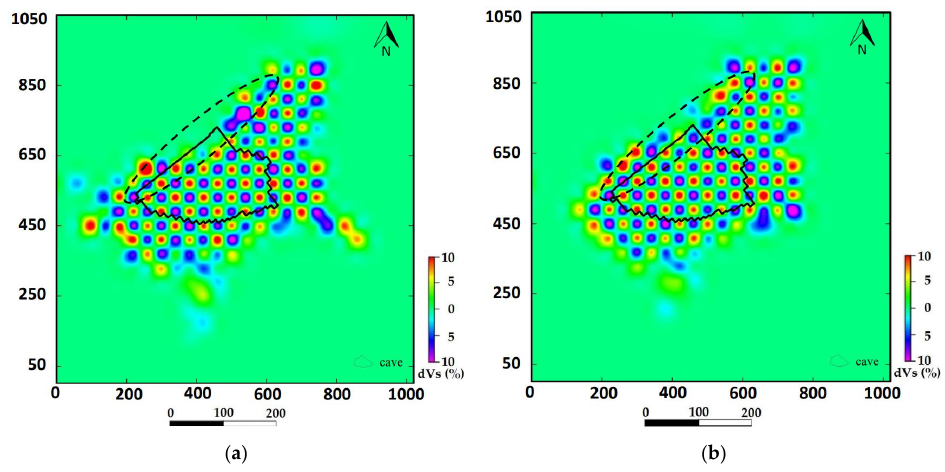
Figure 10. ( a ) The results of the Checkerboard Resolution Test Vs scenario following the facilities in the abutment zone (elevation 1620 msl), ( b ) The results of the Checkerboard Resolution Test Vs off- facilities scenario in the abutment zone (elevation 1620 msl). The cave is indicated by a black triangle.